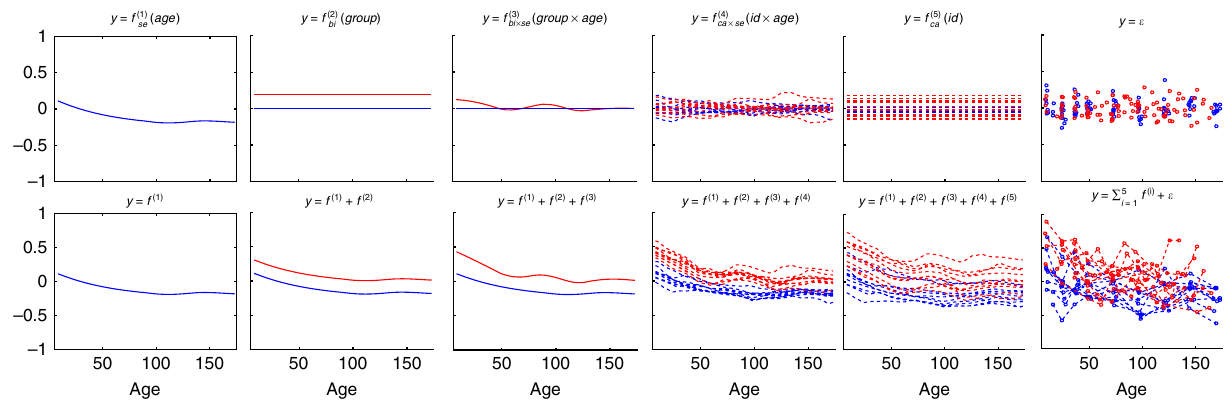
Fig. 5 Predicted components and cumulative effect for protein Q7LGC8 (Proteomics data set). Top panel shows contributions of individual components and lower panel shows cumulative effects. Red lines are cases and blue lines are controls. Bottom right panel shows the Supplementary Fig. 1. Glucose-induced secretion of Prosaposin has been observed from a murine pancreatic beta-cell line 17 .